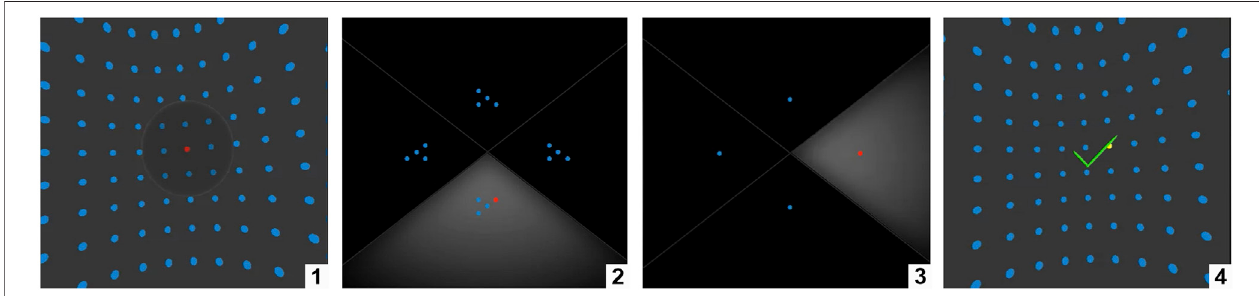
FIGURE 1 | EyeSQUAD selection process (monocular view): 1. main scene (red dot: target, blue dot: distractor), 2. fi rst QUAD-menu progressive re fi nement, 3. later QUAD-menu progressive re fi nement(s), 4. back to the original scene.